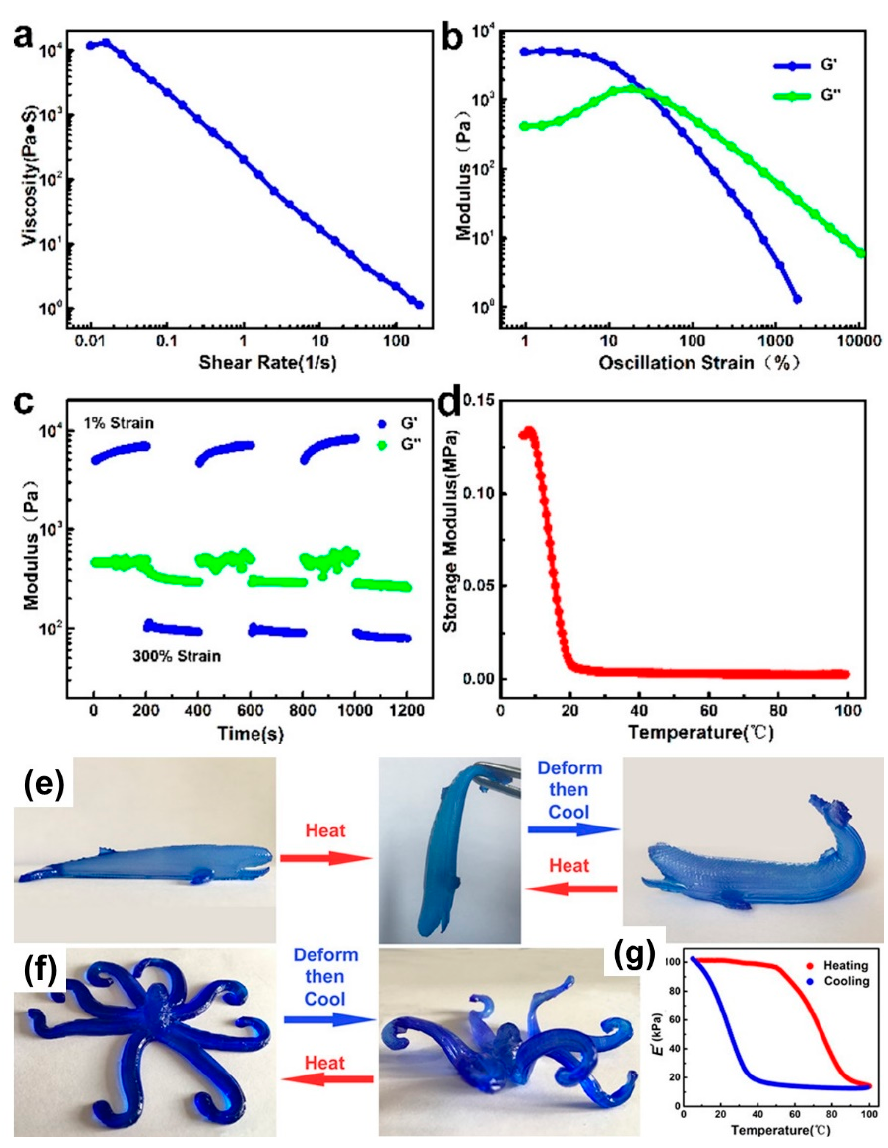
Figure 8. Rheological behaviors of the agarose/AM/Laponite 4D ink at 95°C. Flow rheology pattern showing viscosity against shear rate ( a ). Oscillatory rheology pattern showing shear storage modulus (G ′ ) and shear loss modulus (G ″ ) evolution of inks used, increasing shear strain ( b ). Oscillatory rheology pattern showing modulus evolution of inks between 1% and 300% strain ( c ). The storage modulus variation of 4D ink during cooling ( d ). Four-dimensional printing product printed by 4D ink: a whale-like hydrogel was used as a model schematic for the 4D transition process ( e ), the softening and hardening cycles of an octopus-like gel ( f ), the storage modulus ( e ) variation of 4D gel during heating and cooling cycles measured by rheology ( g ). Reproduced from [152] with permis- sion.